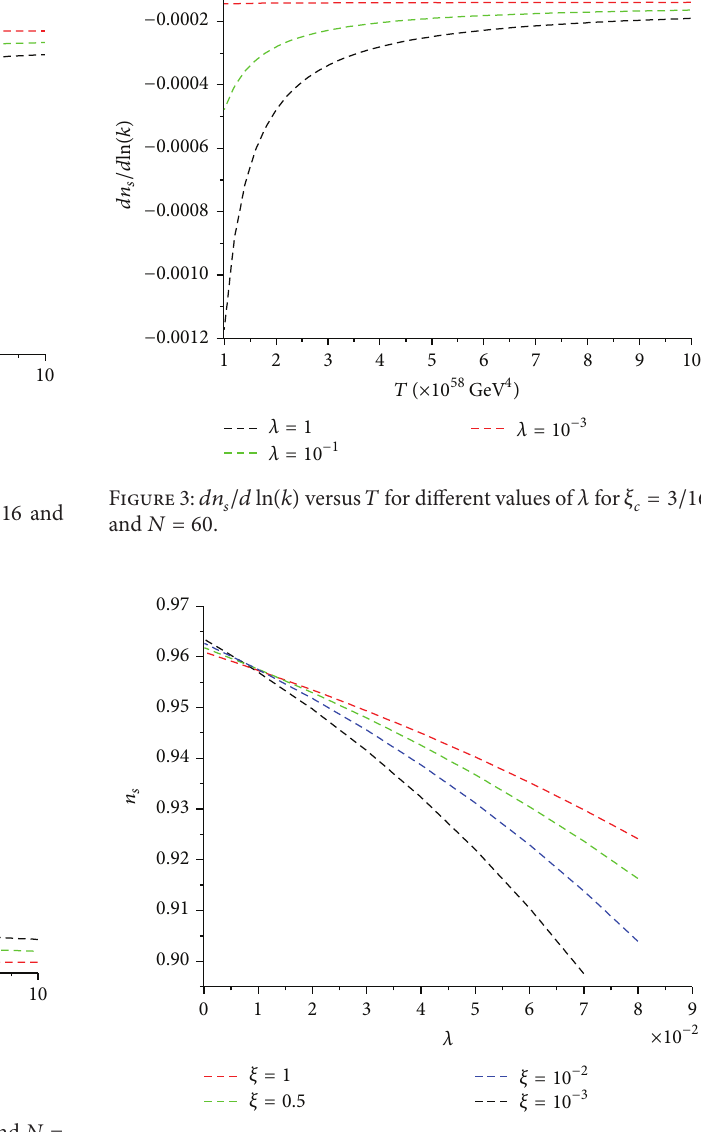
Figure 4: 𝑛 𝑠 versus 𝜆 for different values of 𝜉 for 𝑇 = 5 × 10 58 GeV 4 and 𝑁 = 60